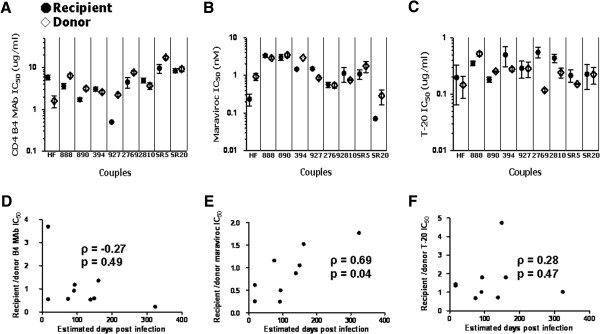
Recipient and transmitter envelope viruses have no significant differences in sensitivity to receptor and fusion blockers. IC50s to CD4 antibody (A), Maraviroc (B), and T-20 (C) among recipient (hollow circle) and transmitter (filled rectangle) envelope viruses. The x-axis shows the couple ID. Values represent means from a minimum of 3 independent experiments with error bars showing the standard deviation. Correlation between interval from estimated infection to sampling and recipient to transmitter IC50 ratios to CD4 antibody (D), Maraviroc (E), and T-20 (F). Each graph shows a correlation coefficient with a Spearman rank correlation p - value.